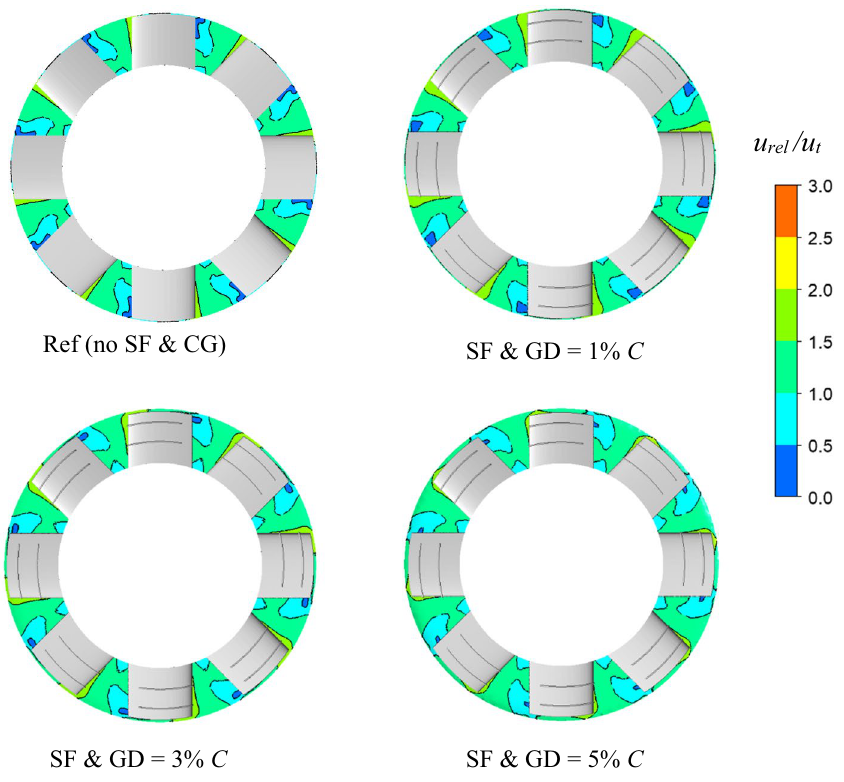
Figure 13. Comparison of velocity contours at 10% C from the blade surface on the suction side of the blade at φ =